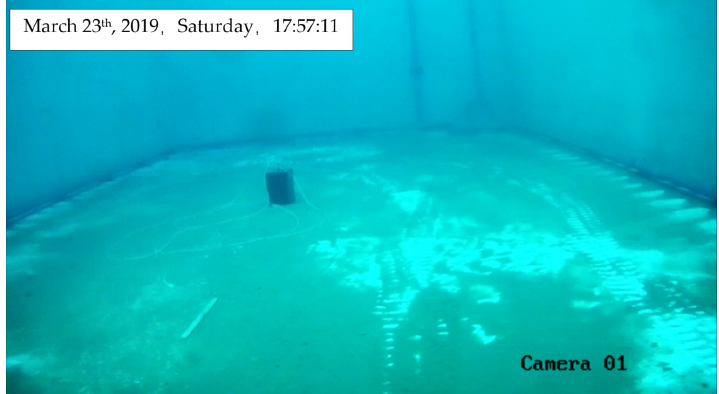
Figure 12. Walking trajectory of tank test.